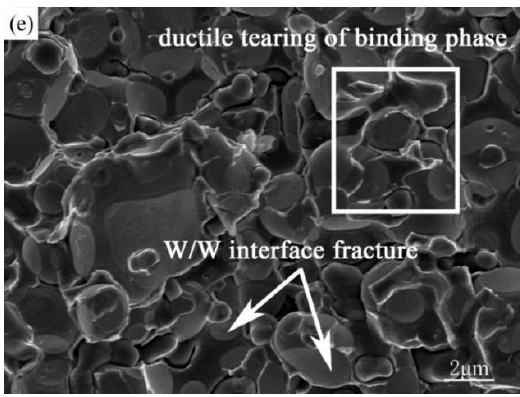
Figure 7. Fracture morphology of W-6Ni-4Mn alloys at different sintering temperatures. ( a ) 1000 °C, ( b ) 1050 °C, ( c ) 1100 °C, ( d ) 1150 °C, and ( e ) 1200 °C.